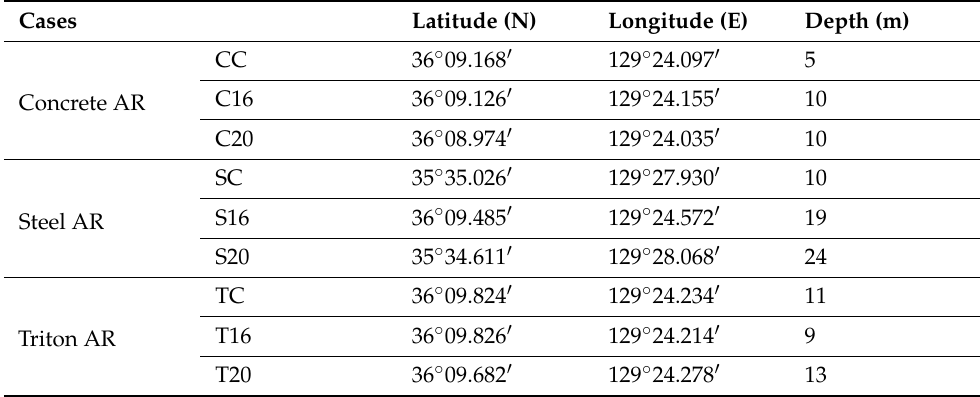
Table 1. Location and depth of sites for control and